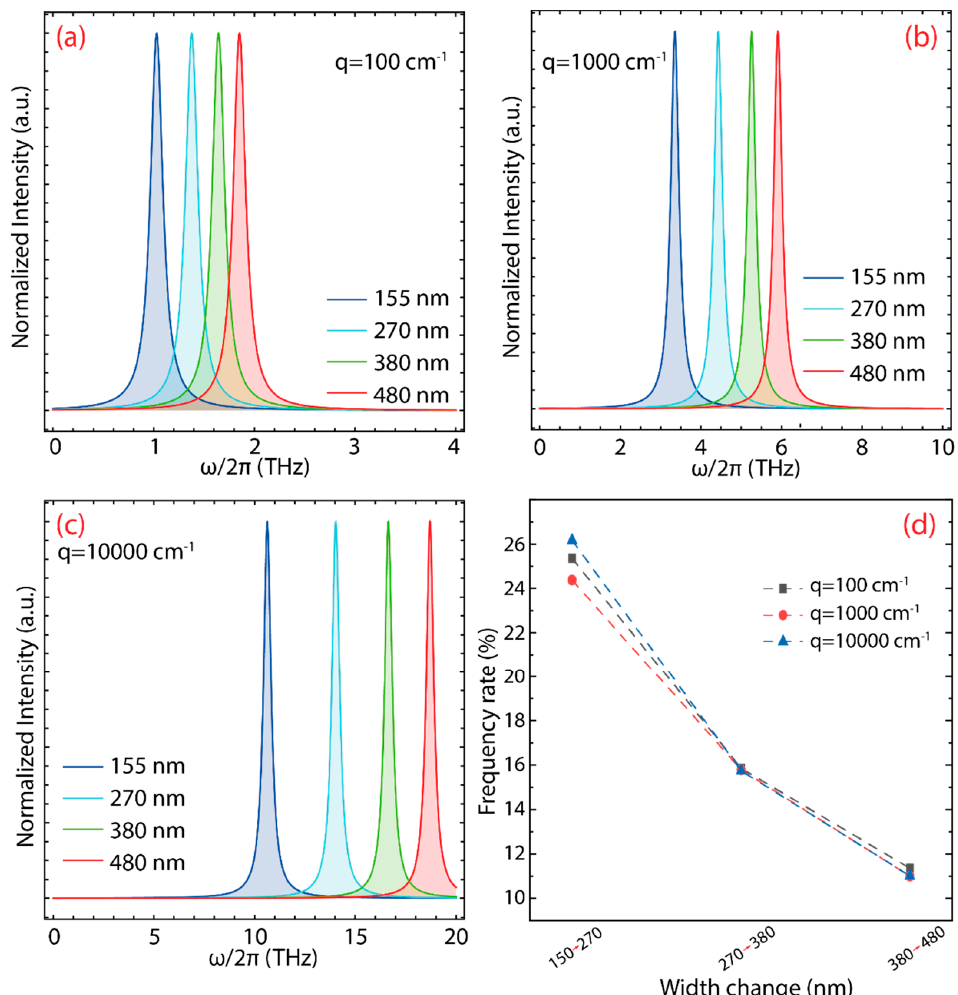
Figure 6. ( a ) Plasmon excitation lifetime ( ≤ 4 THz) for different ribbons widths at q = 100 cm − 1 . ( b ) Plasmon excitation lifetime ( ≤ 10 THz) for different ribbons widths at q = 1000 cm − 1 . ( c ) Plasmon excitation lifetime ( ≤ 20 THz) for different ribbons widths at q = 10,000 cm − 1 . ( d ) Percentage variation in plasmon frequency by increasing ribbon width for three different q values ( q = 100, 1000, 10,000 cm − 1 ). The parameters of Equation (4) have been fixed as: N 2 D = 1.0 × 10 12 cm − 2 , θ = 0, v = 1.0 × 10 13 s − 1 , and v F = 0.829 × 10 6 m s − 1 . The plasmon spectra were calculated using